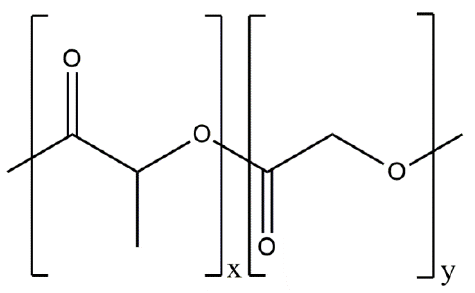
Figure 19. Schematic representation of the chemical structure of poly(lactide-co-glycolide).